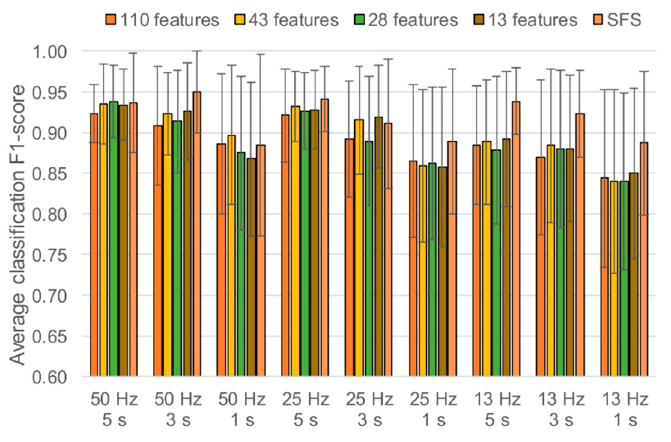
Figure 7. F1-scores (mean ± SD) averaged over all activities using different feature sets, window lengths and sampling frequencies.